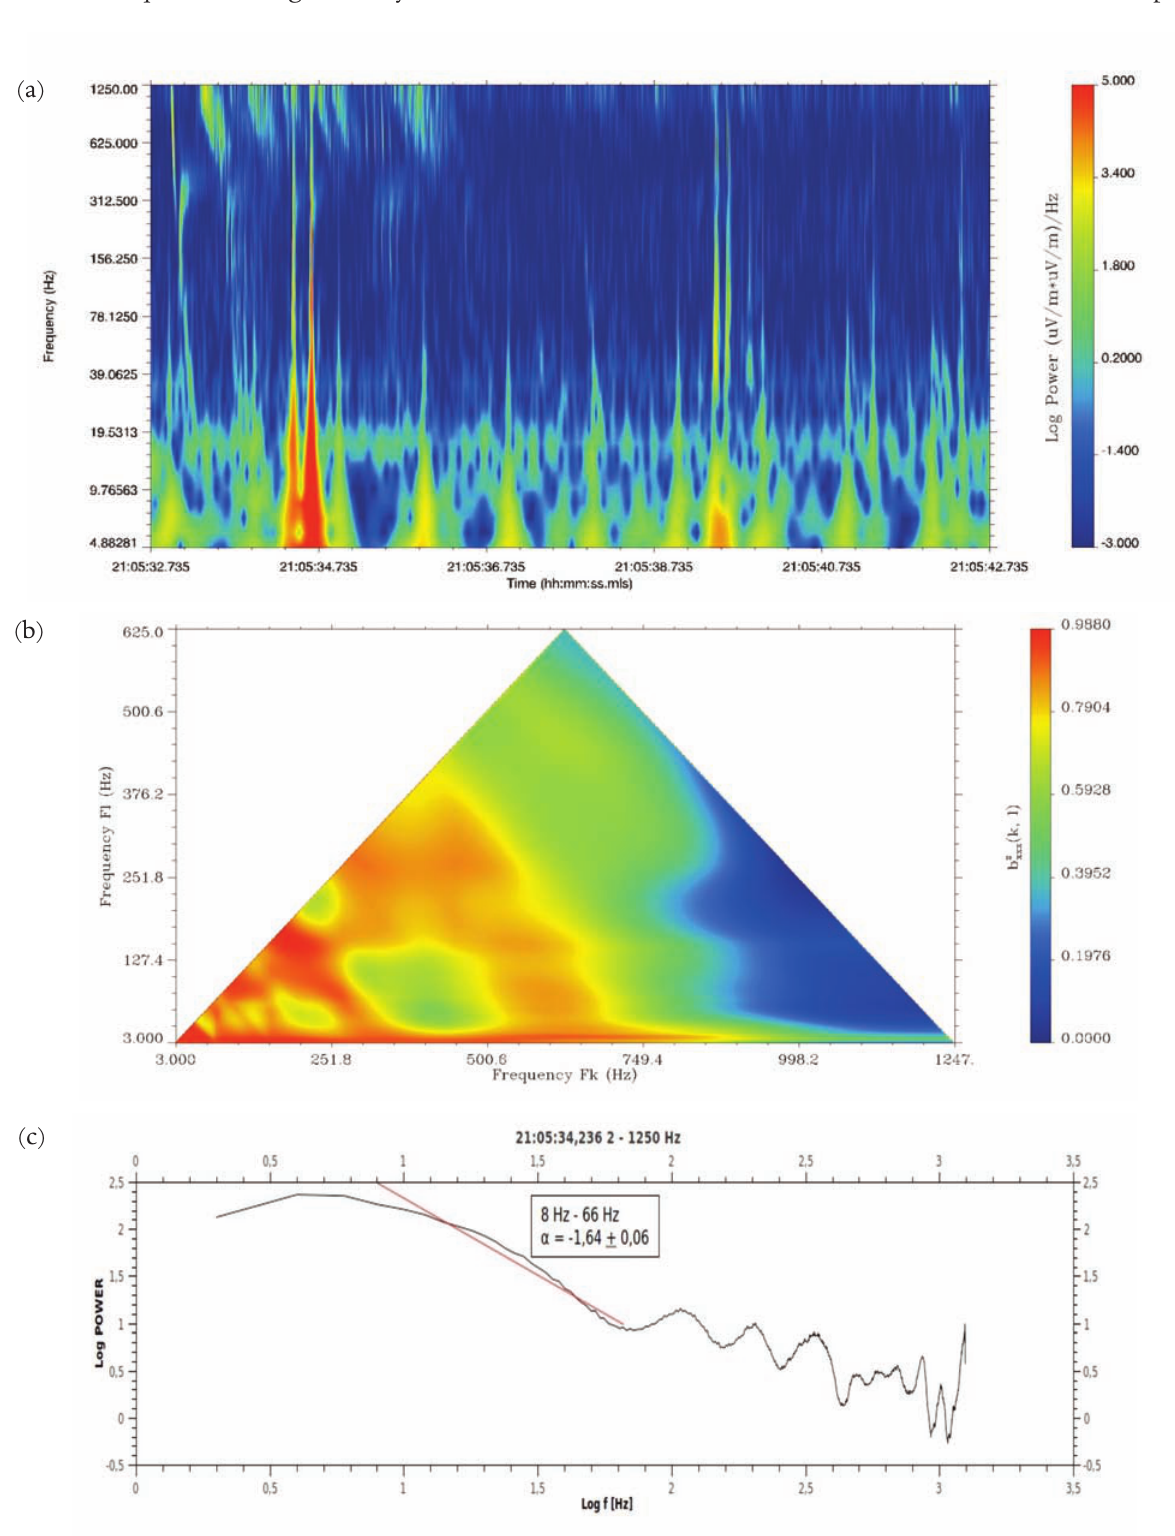
Figure 5. (a) Wavelet spectrogram of the broad-band emission in the ELF range at a greater distance from the epicenter (677 km), although still in the zone of seismic influence, in terms of a Dobrovolsky definition. The color scale is as in Figure 2. (b) Bispectrum of the Ex signal in ELF range. For description, see Figure 2b. The pattern of the frequency regions with strong 3-wave interactions is more complicated than for April 1, although a clear signature of the turbulent cascade is seen in the lower part of the panel. (c) Single spectrum with slope a c